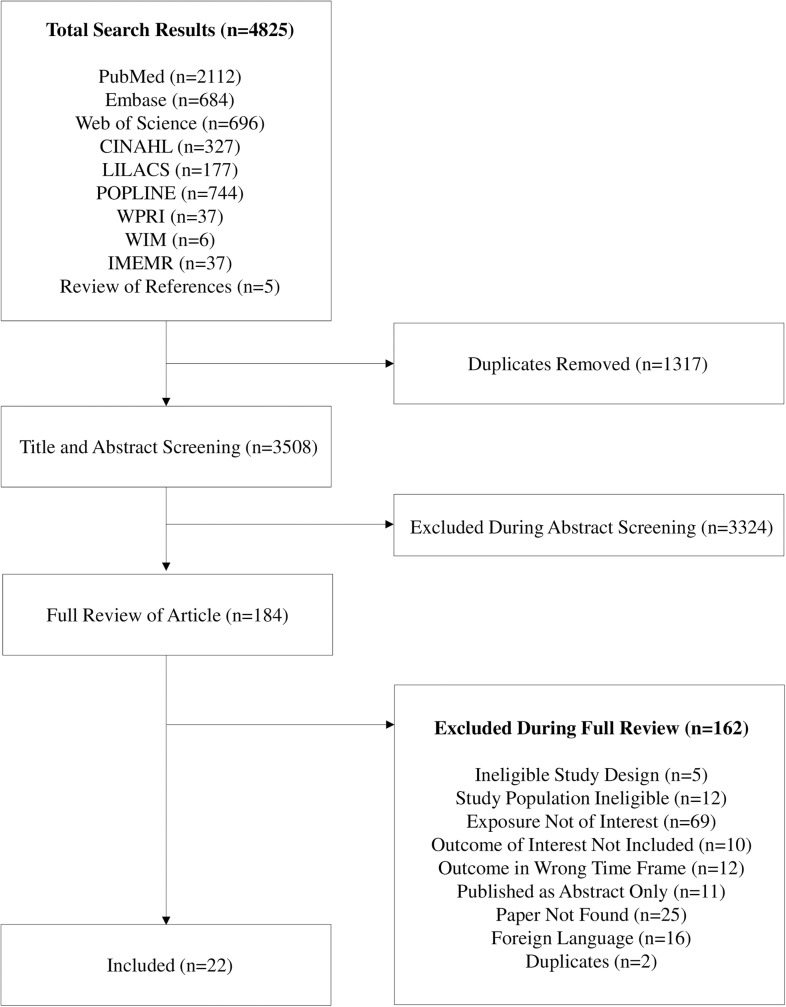
Flow diagram of search results and screening process.